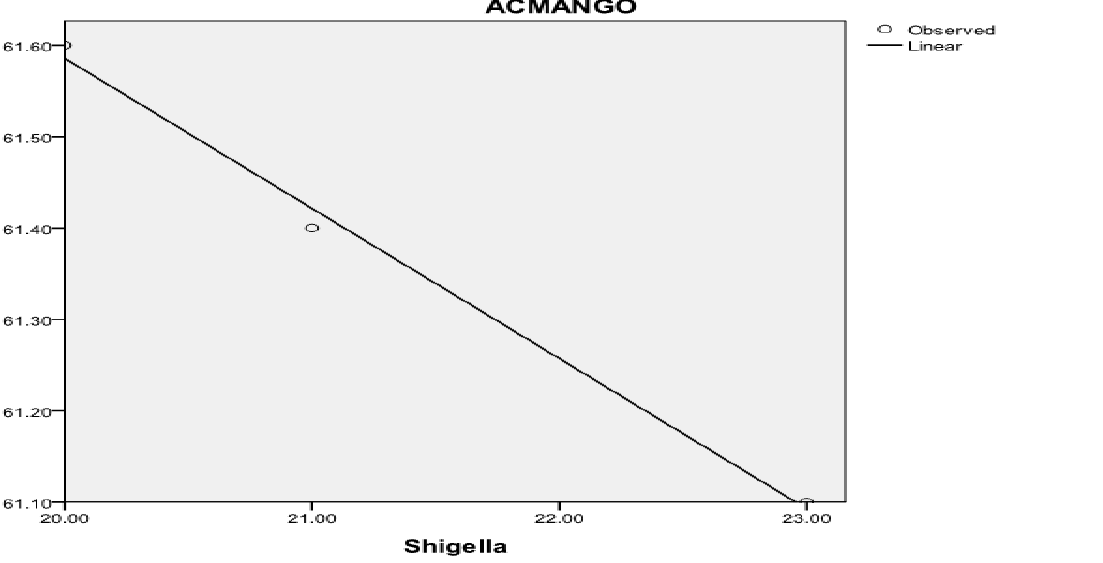
Figure 7. Correlation between treated AC of date’s stones and Shigella spp.